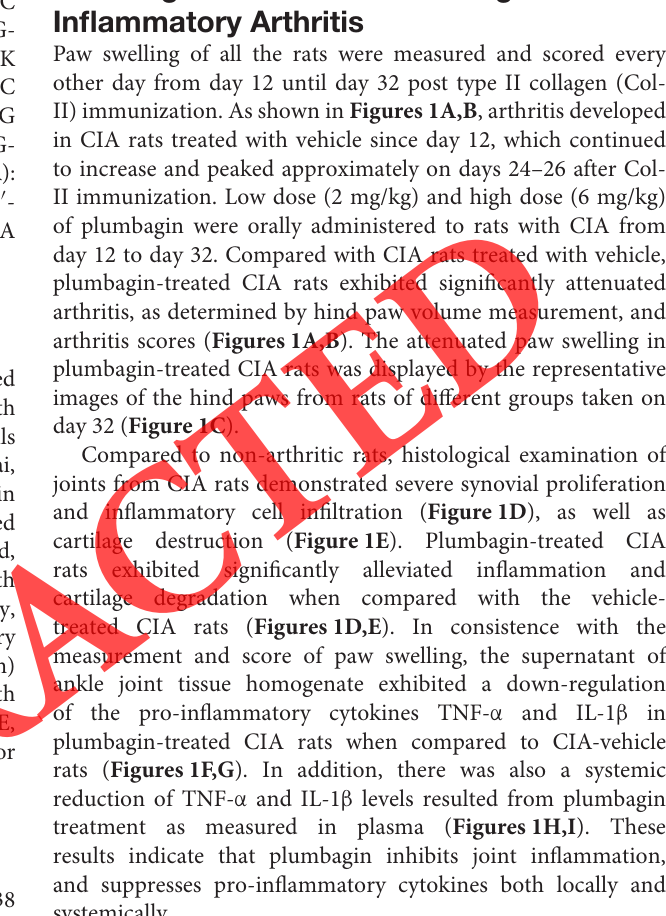
FIGURE 1 | in the supernatant of hind paw joint homogenate as measured by enzyme-linked immunosorbent assay (ELISA) on day 32. (H,I) Protein levels of TNF- α and IL-1 β in rat plasma as measured by ELISA on day 32. Quantitative results are presented as mean ± SEM, and n = 10/group. ## P < 0.01 vs. non-arthritic control rats. * P < 0.05; ** P < 0.01 vs. vehicle-treated CIA